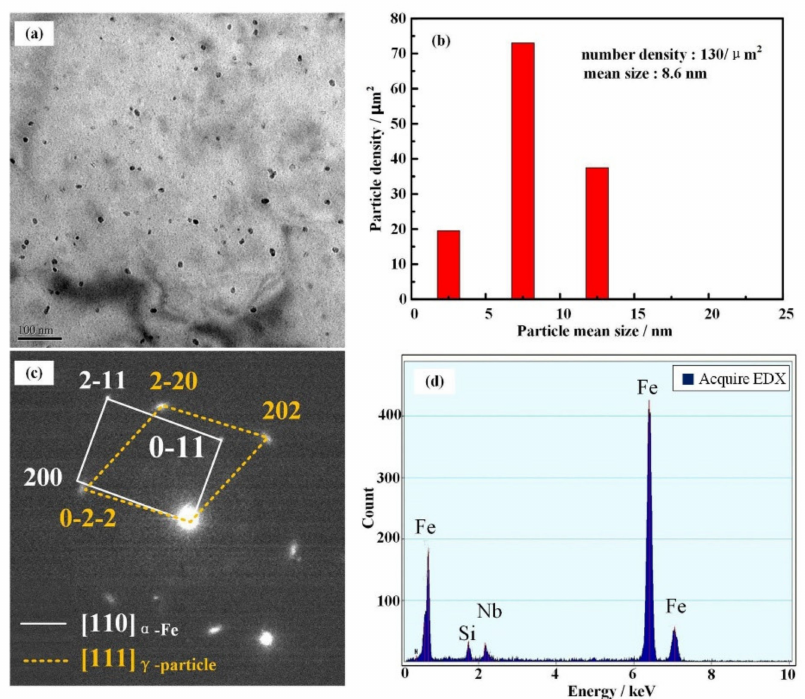
Figure 4. TEM micrograph for the precipitates ( a ) and its size distribution ( b ) in the hot rolled strip, as well as the SADP ( c ) and EDX spectrum ( d ) of precipitates.